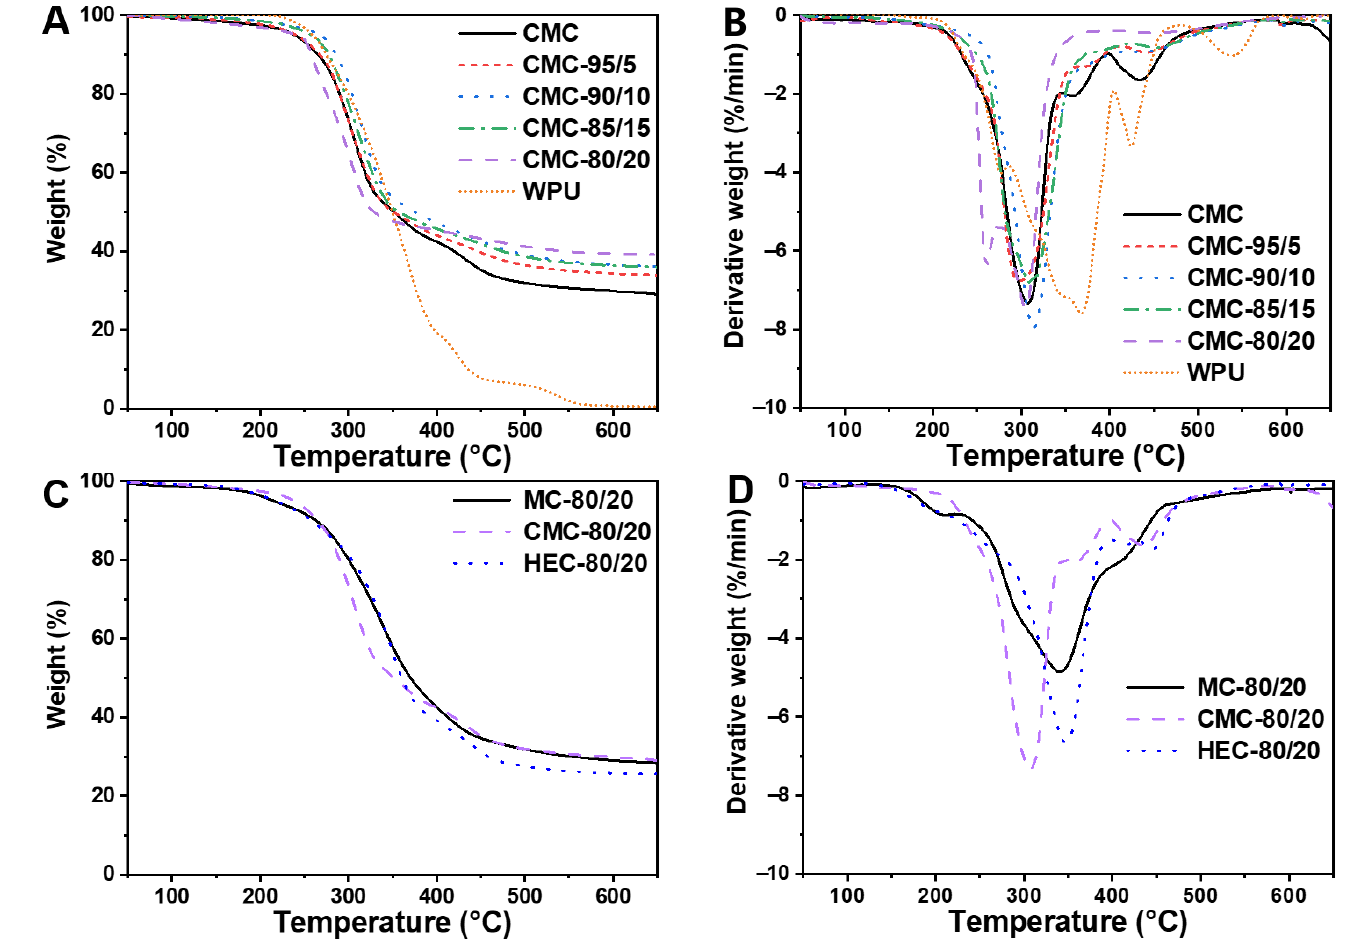
Figure 6. TGA curve of CMC/WPU composite aerogel with different weight ratios; ( A ) TG, ( B ) DTG. TGA curve of cellulose/WPU composite aerogel with different celluloses; ( C ) TG, ( D ) DTG. Table 4. TGA analysis parameters of cellulose/WPU composite aerogel with different weight ra- tios.